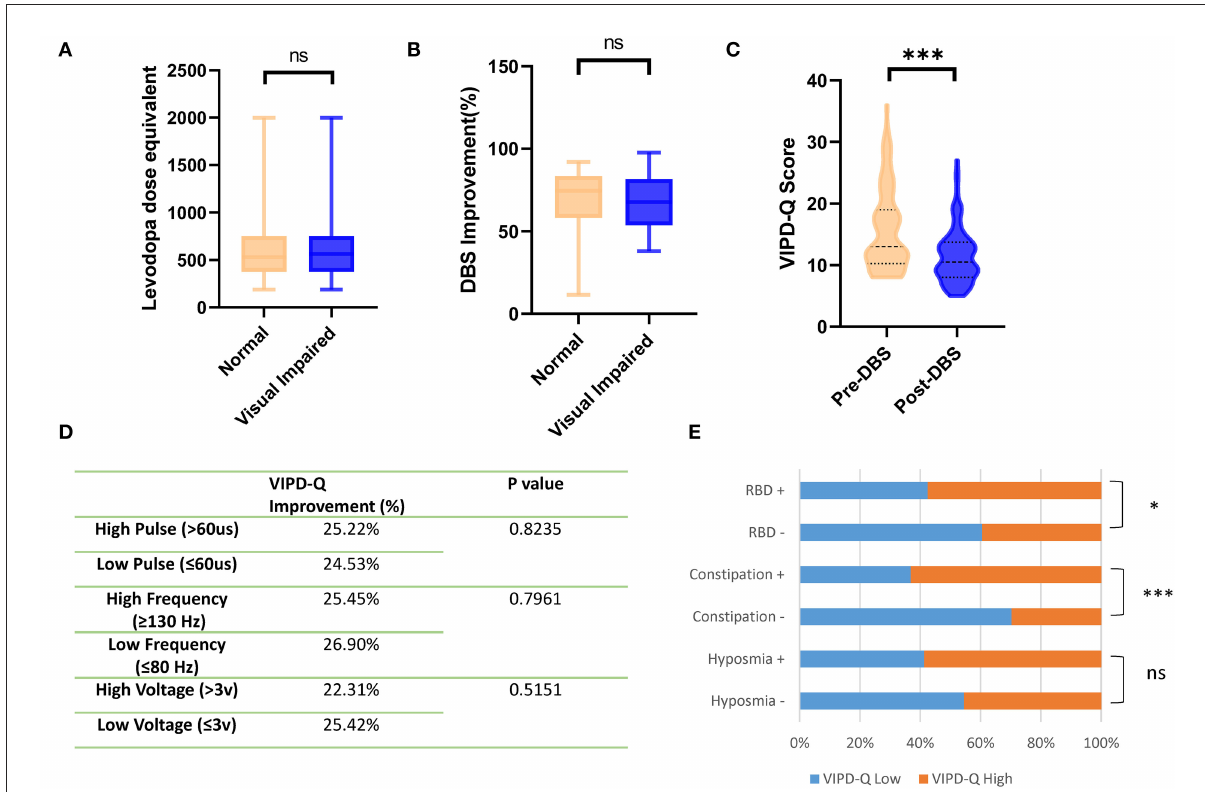
FIGURE2 DBS and non-motor symptoms affected VIPD-Q scores in PD. (A,B) Groups with different VIPD-Q score presented similar LED and DBS improvements (C) . DBS improved VIPD-Q scores. (D) Stimulation parameter changing did not affect the VIPD-Q score. (E) PD patients with RBD or constipation had higher percentage of visual impairment (VIPD-Q > 6). ns, no significant and *** p < 0.001. DBS, deep brain stimulation; RBD rapid eye movement (REM) sleep behavior disorder; VIPD-Q, Visual Impairment in Parkinson’s Disease